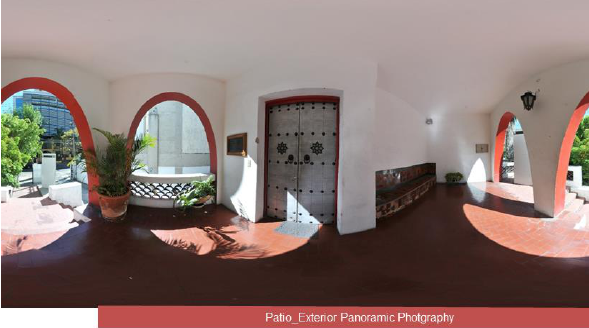
Fig.12 Panoramic photography of the exterior front patio. Author: Mario Santana